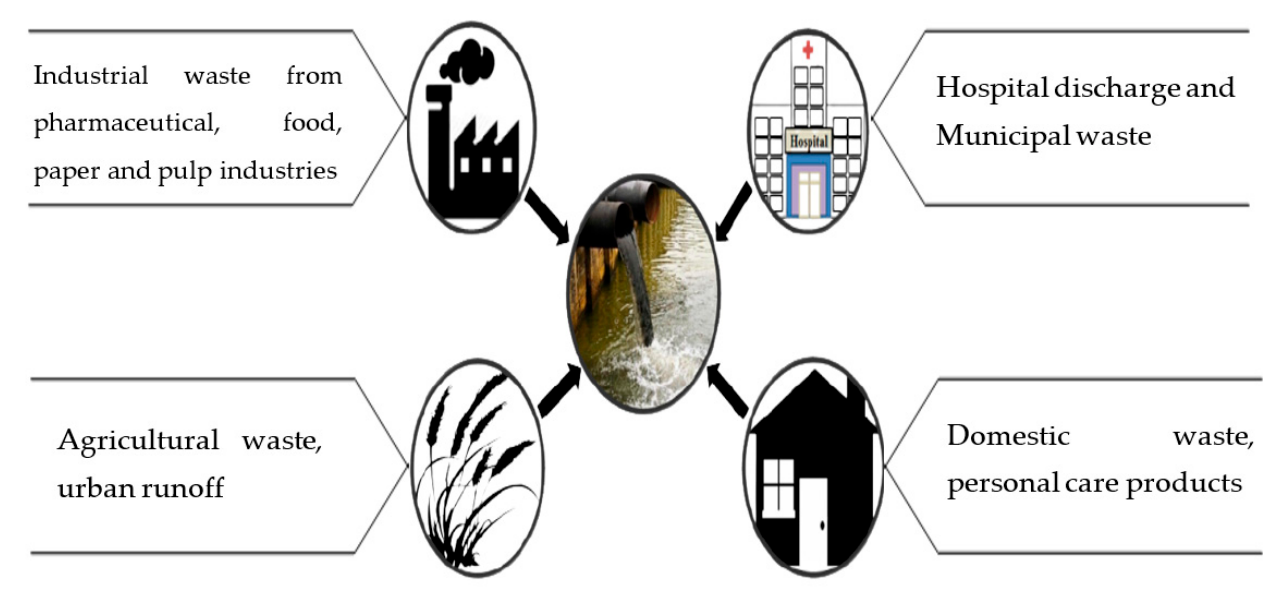
Figure 1. Various sources of wastewater.